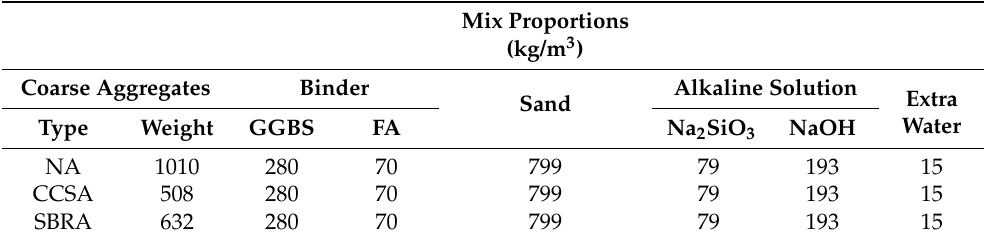
Table 5. Mix proportions of